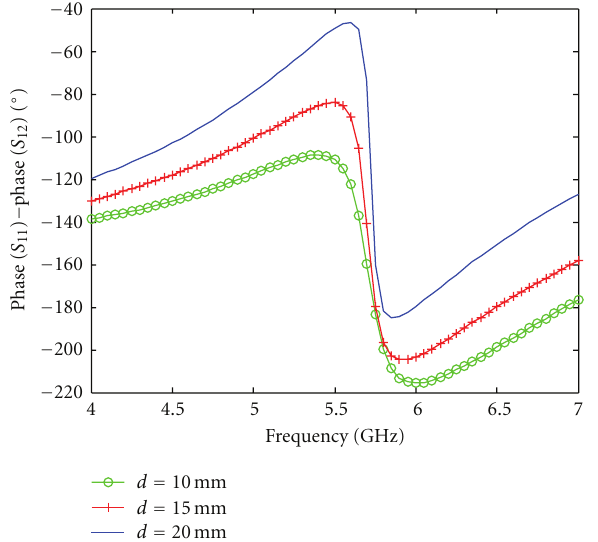
Figure 4: Calculated phase di ff erences between S 11 and S 12 of array no. 1.